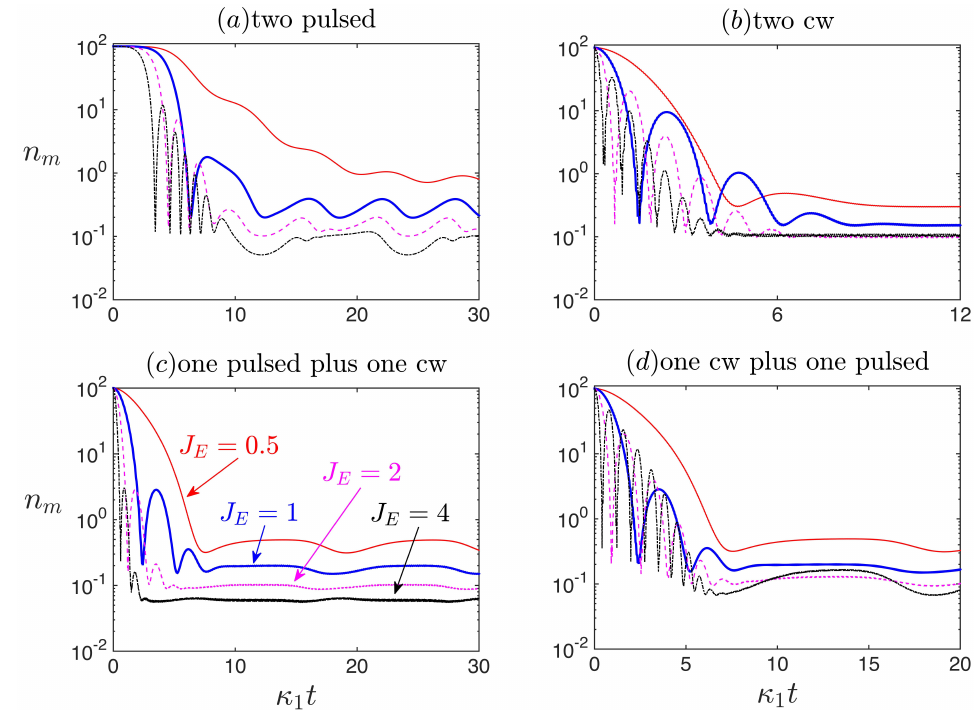
Figure 2. Dynamical evolution processes of the thermal phonon number under different combinations of a Gaussian pulsed drive and CW drive. Each cavity is driven by one drive, and the effective coupling intensity is J E = 0.5,1,2,4 for red, blue, pink, and black lines, respectively. For a pulsed field, the parameter J E is determined by its peak amplitude E . ( a ) Both drives are Gaussian pulsed. ( b ) Both drives are CW ones. ( c ) One Gaussian pulsed drive and one CW drive are applied to the left and right cavity, respectively. ( d ) The pulsed one and CW one in ( c ) are interchanged in their positions. The re-scaled optomechanical coupling constant is g m / κ 1 = 10 − 5 ; the re-scaled mechanical frequency is ω m / κ 1 = 100; the re-scaled mechanical damping rate is γ m / κ 1 = 10 − 3 ; the initial thermal occupation is n th = 100. The ratio of the damping rates of the two cavities is κ 2 / κ 1 = 1 for J E = 0.5 and κ 2 / κ 1 = J E for J E = 1,2,4, so that most results in ( c ) are not the same as those in ( d